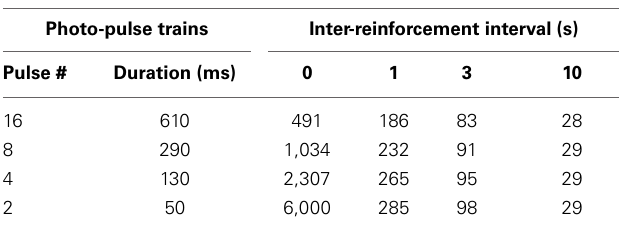
Table 1 | Dependency of the numbers of photo-pulse trains obtainable per 5min on photo-pulse trains durations and inter-reinforcement